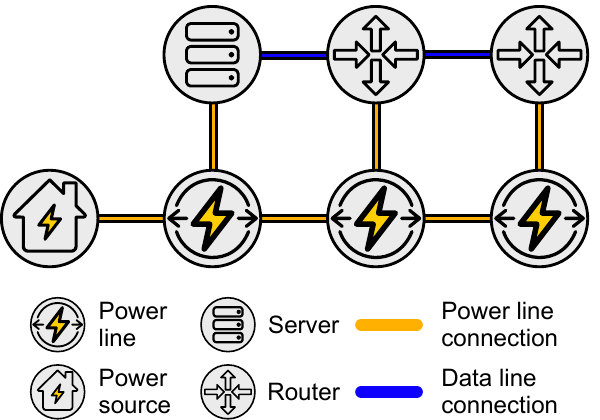
Figure 7. Example of connecting both simulated networks